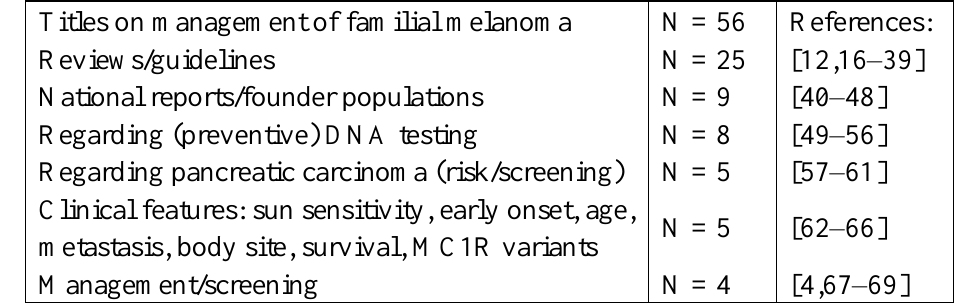
Table 3. Fifty-six key-references with regard to management of familial melanoma published after 1 January